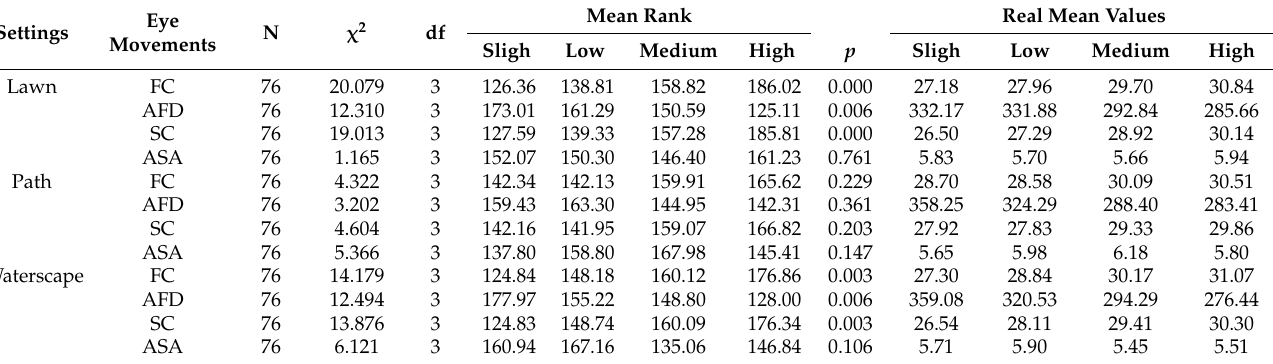
Table 3. The Kruskal–Wallis test results of eye movement metrics within each type of setting.